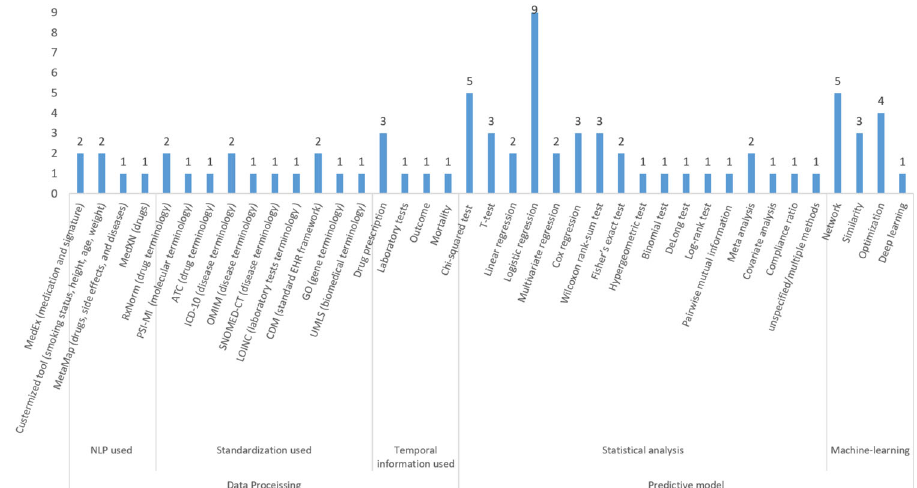
Fig. 3 Distribution of different data processing methods and the predictive